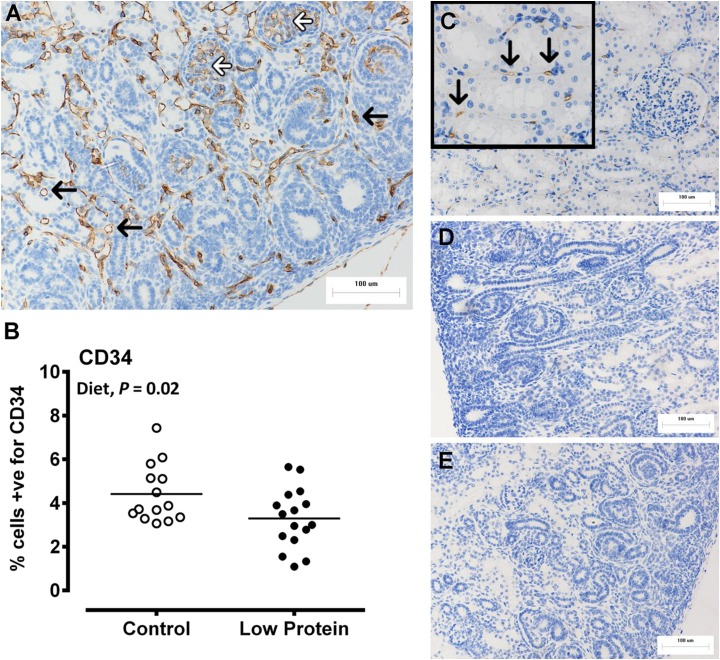
Fetal kidney microvasculature (density of endothelial cells; CD34) is blunted by maternal low protein diet. Fetal kidney microvasculature was indirectly determined using immunohistochemistry and quantification of cells positive for CD34. A) Representative micrograph of the nephrogenic zone, CD34 staining is brown, black arrows indicate peritubular capillaries, white arrows show staining of glomerular capillaries. B) Dot plot of individual data points for control and LP-exposed fetuses (control: male, n=8; females n=7; LP diet: male, n=8; female, n=8). C) Positive control, adult ovine kidney. D, E) Negative controls, omission of primary antibody (D) and rabbit IgG (E). All images are ×200. Data were analyzed by the general linear mixed model for the fixed effects of diet, sex, and their interaction term (diet×sex) using Genstat 15. NS, nonsignificant. Values of P < 0.05 were considered significant.